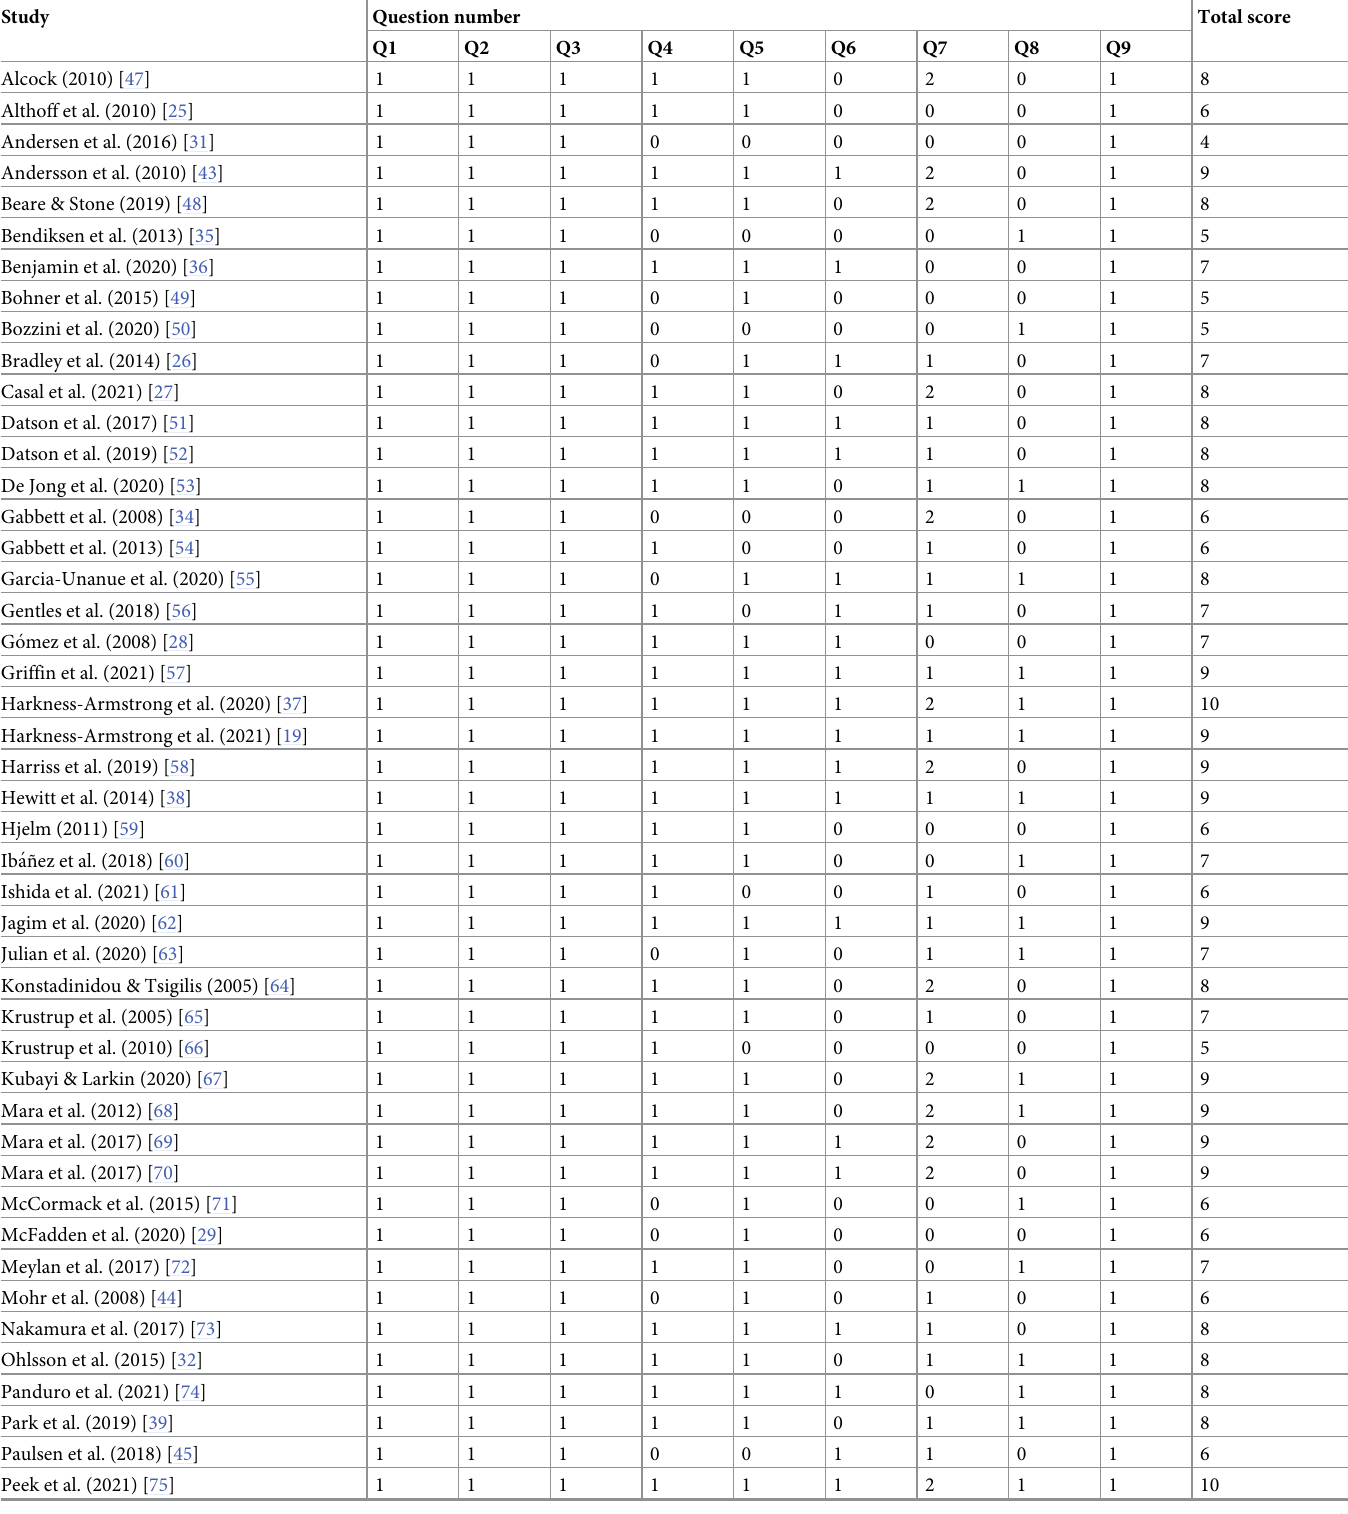
Table 2. Methodological quality of included